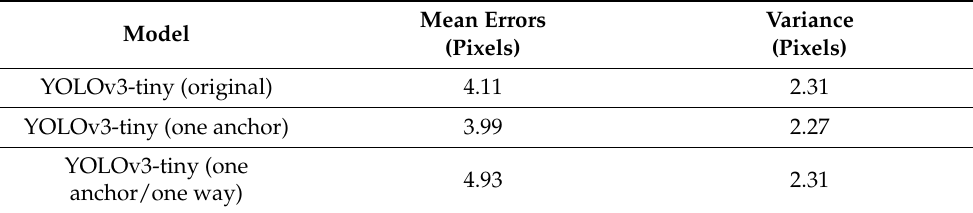
Table 6. Comparisons of the visible-light pupils’ center tracking errors among the three YOLO-based models by using the datasets of person 9 to person 16 for the cross-person testing mode.